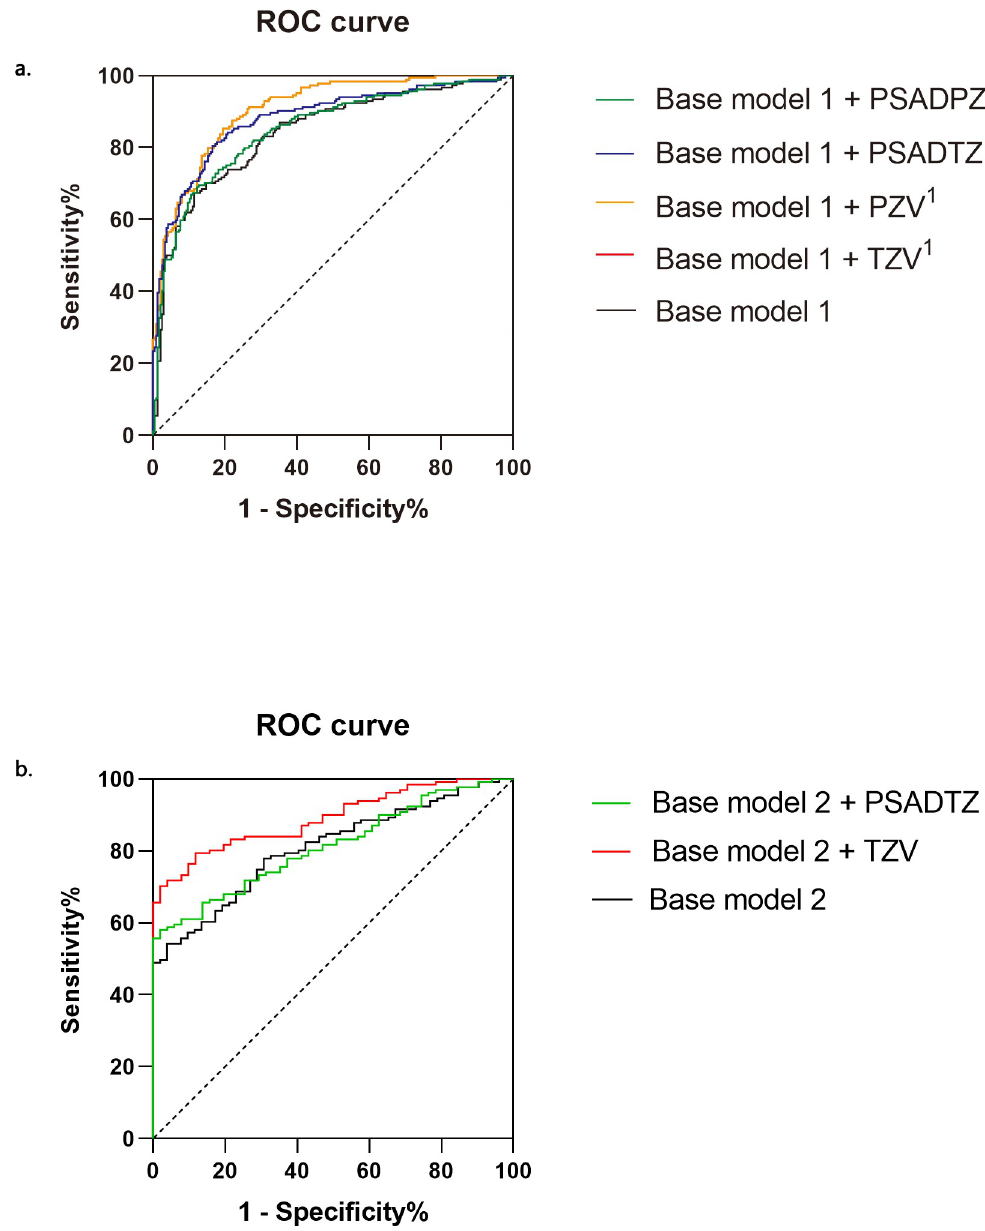
Fig 2. Receiver-operating characteristic curves depicting the accuracy of predictors of PCa (a.) and HR-PCa (b.) at the initial biopsy. Base model 1, PSA + PV + PSAD + MR; Base model 2, PV + PSAD + MR. 1 Base model 1 + TZV and Base model 1 + PZV had the same